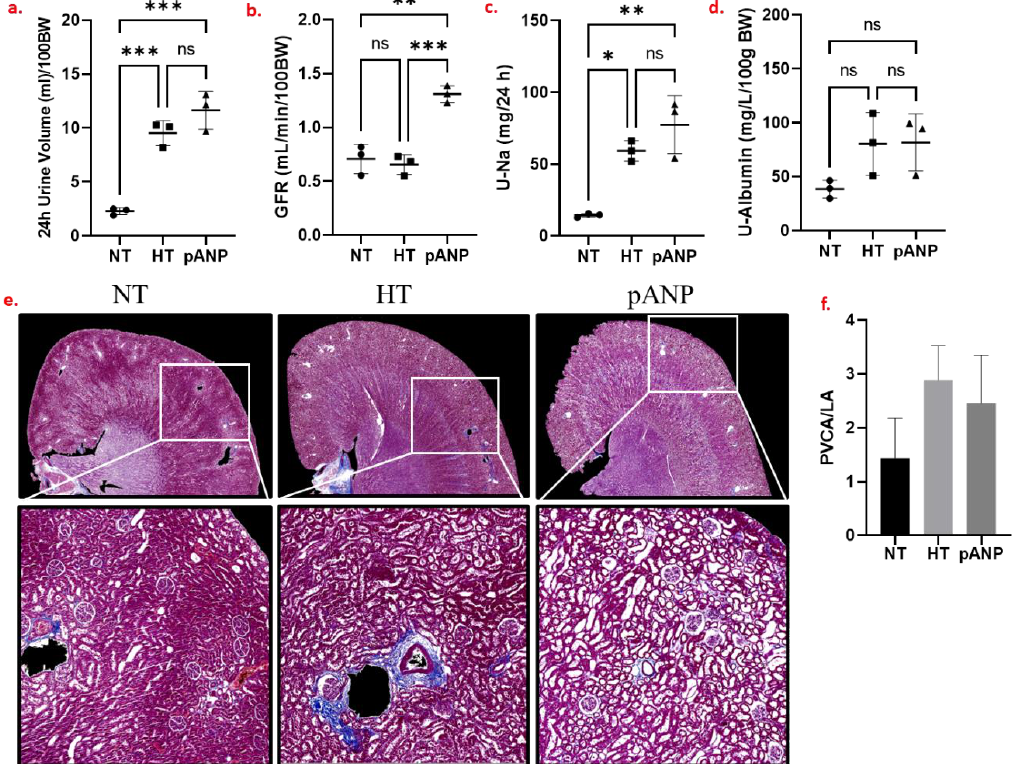
Figure 1. ( a – d ) Renal functional data obtained for NT (circles), HT (squares), and pANP (triangles) rats. Zero (n.s.) or low (*) to high (***) statistical significance for the differences between data are reported. ( e ) Masson’s trichrome staining of representative formalin-fixed paraffin-embedded (FFPE) kidney sections. ( f ) Perivascular collagen deposition. NT, normotensive; HT, hypertensive; pANP, proANP 31–67 -treated; BW, body weight; GFR, glomerular filtration rate; U-Na, urinary sodium; U- albumin, urinary albumin; PVCA/LA, perivascular collagen area/lumen area. The data are presented as mean ±